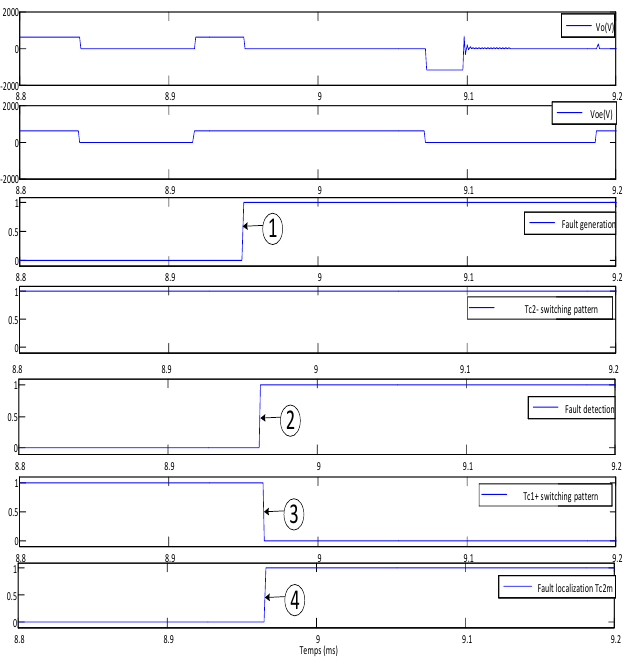
Fig.14 : Zoomed Simulation results when Tc2- is